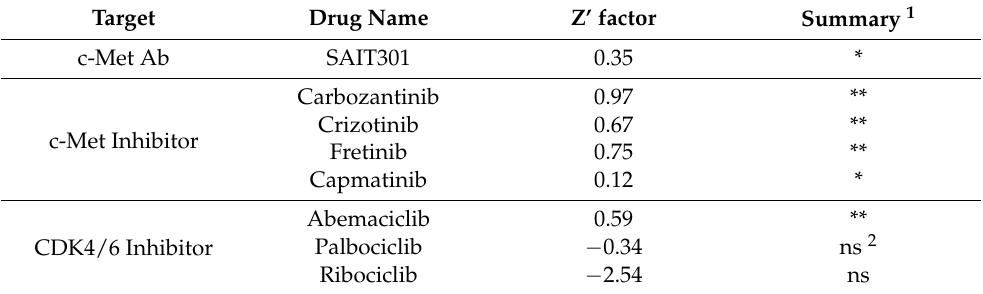
Table 2. Z’ factor of phospho-c-Met intensity between high and low concentration in each inhibitor. Target Drug Name Z’ factor Summary